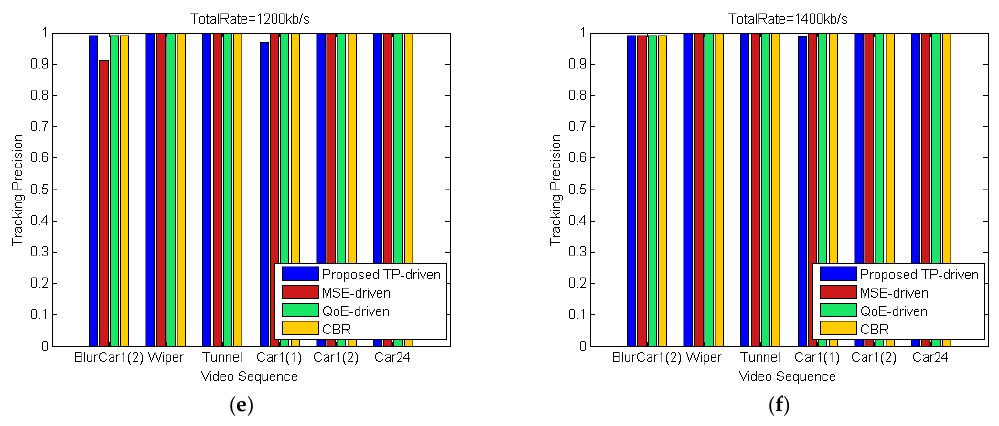
Figure 13. Tracking precision of each video under different total rate constraints. The packet loss of each video is 1%: ( a ) Total rate = 400 kb/s; ( b ) Total rate = 600 kb/s; ( c ) Total rate = 800 kb/s; ( d ) Total rate = 1000 kb/s; ( e ) Total rate = 1200 kb/s; ( f ) Total rate = 1400 kb/s.